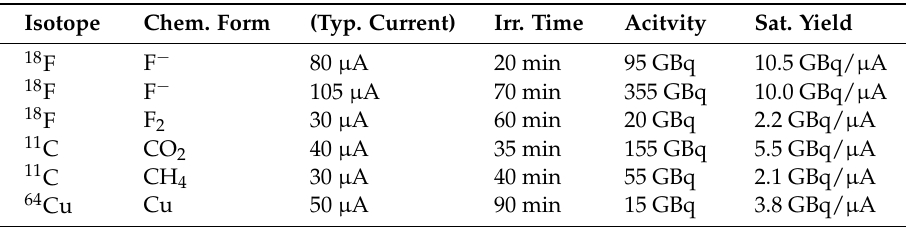
Table 2. Typical production parameters of the TR-Flex at the